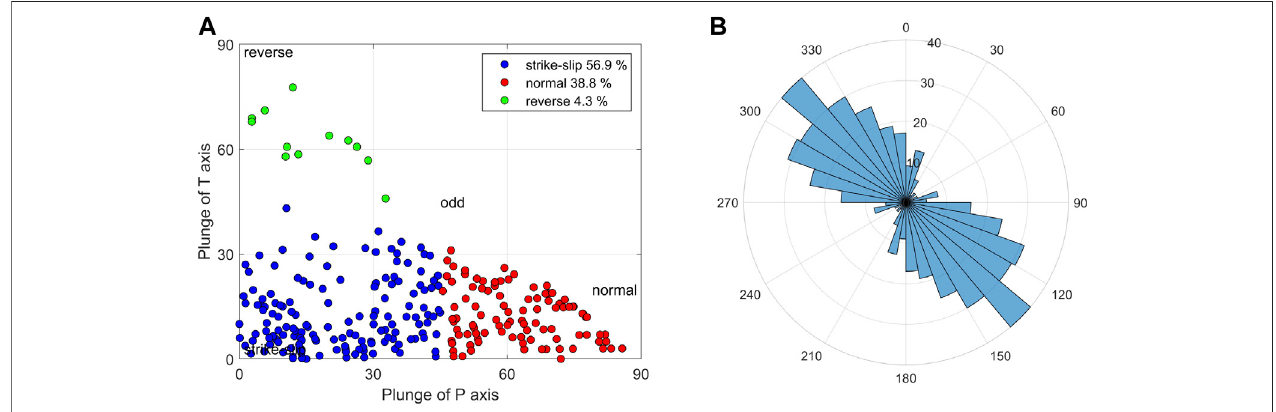
FIGURE 6 | (A) Classi fi cation and distribution of all focal mechanisms on the basis of P- and T-axis plunge. (B) Rose histogram of T-axis direction of all focal mechanisms.